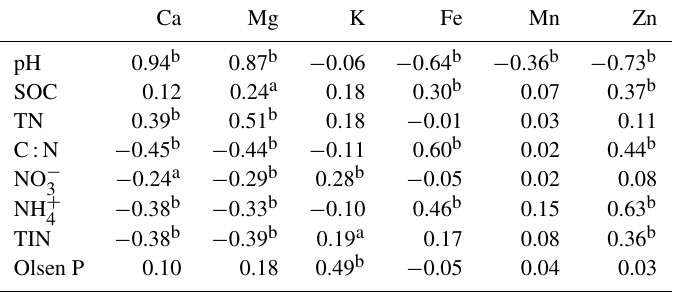
Table 2. Regression statistics relating soil base cations and micronutrients to other soil physicochemical parameters under all trees and shrubs across three sampling sites. The TN, C:N, TIN, and Olsen P represent soil total nitrogen, SOC to TN ratio, total inorganic nitrogen, and Olsen phosphorus.